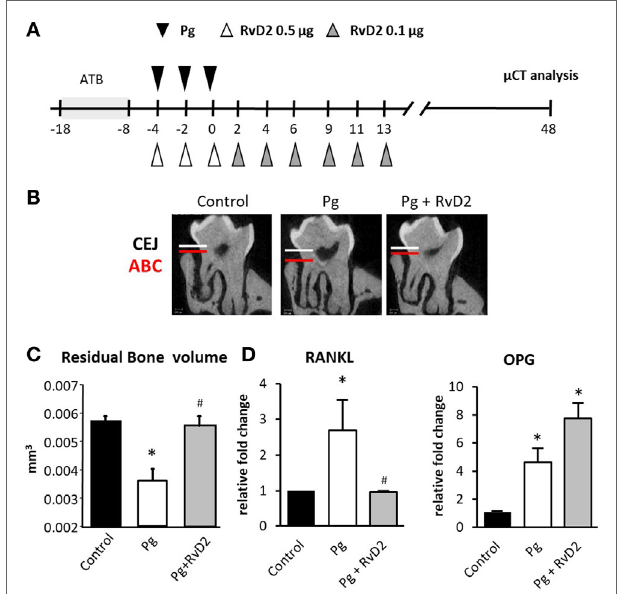
FigUre 1 | Resolvin D2 prevents alveolar bone loss by shifting the RANKL/ osteoprotegerin (OPG) ratio. (a) Schematic presentation demonstrating the experimental system. Briefly, mice were treated with antibiotic (ATB) in the drinking water ad libitum for 10 days, followed by 3 days of antibiotic-free period. The mice were then infected via oral gavage with 10 9 colony-forming units of Porphyromonas gingivalis in 2% carboxymethylcellulose either with or without RvD2 0.5 µg (i.p.) for the first week and three injections per week with 0.1 µg of RvD2 (i.p.) during the following 2 weeks. Control mice received vehicle only. (B) Representative μ CT sections of the second upper molar demonstrating the impact of RvD2 treatment on the distance between the cemento-enamel junction and alveolar bone crest. (c) 3D quantification of the residual alveolar bone volume 6 weeks after infection. Significant lower residual bone volume was measured in the P. gingivalis- infected group compared to the other groups. Data are presented as the residual volume of alveolar bone in the buccal plate and represent the means of eight mice per group ± SEM. Results are representative of three independent experiments, * p < 0.05 relative to control group. # p < 0.05 relative to Pg group. (D) RANKL and OPG mRNA expression was quantified by Real-Time q PCR 6 weeks after infection (gene/TBP) in the jaw soft and hard tissues surrounding the molars. The presented data represent the means of 6 mice per group ± SEM. Results are representative of two independent experiments, * p <